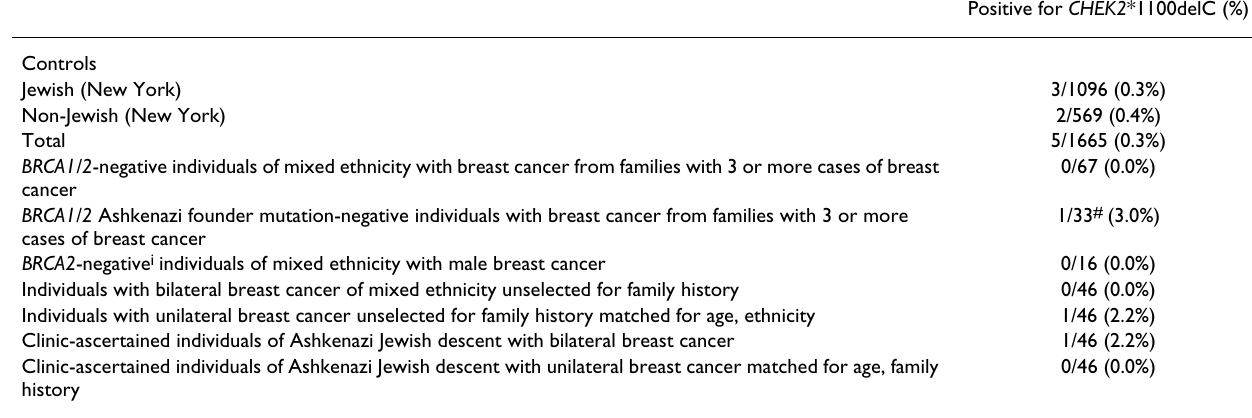
Positive for CHEK2 *1100delC (%)